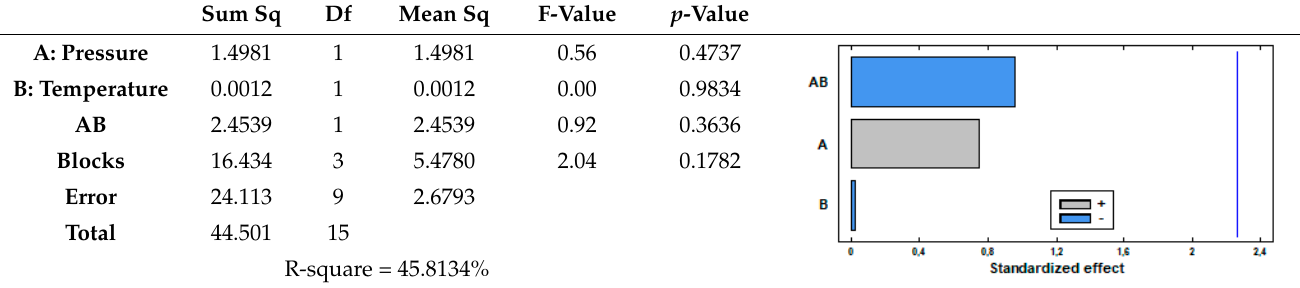
Table 6. ANOVA table and Pareto chart for quadratic model of antioxidant activity of impregnated PETG.